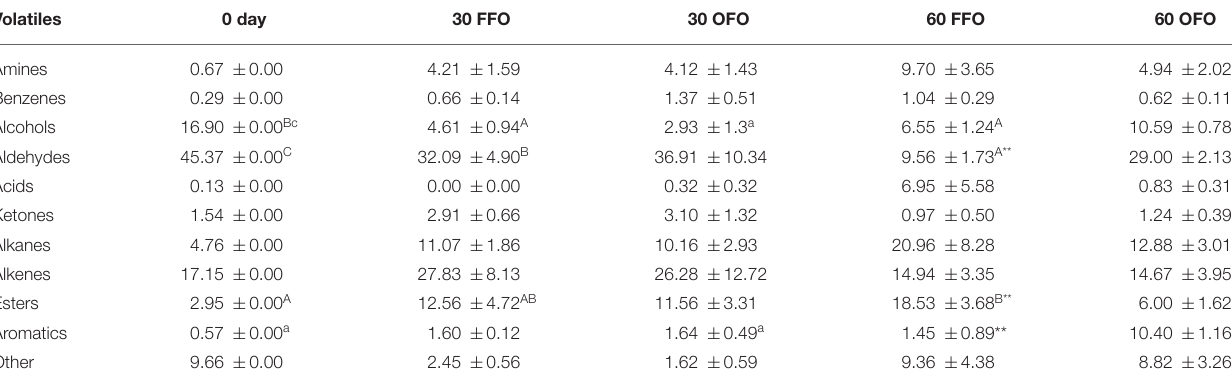
TABLE 6 | Muscle volatile compounds of grouper fed different diets